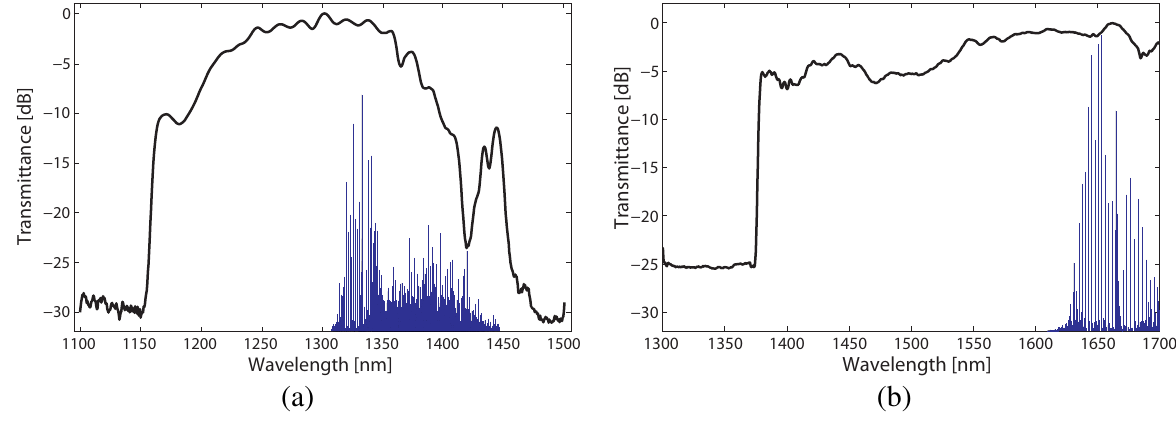
+ 2 ν band, and (b) a 4.9 m long 2 3 3